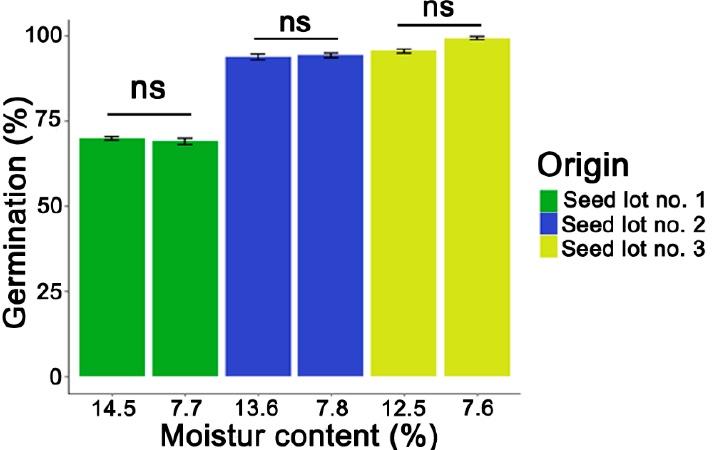
Figure 1. Germination of non-stored non-desiccated and desiccated Populus nigra L. seed lots. Statistical analysis was conducted using the Wilcoxon–Mann–Whitney test. Values marked with the “ns” are not significantly different at p < 0.05. Data represent mean ± SE, n =